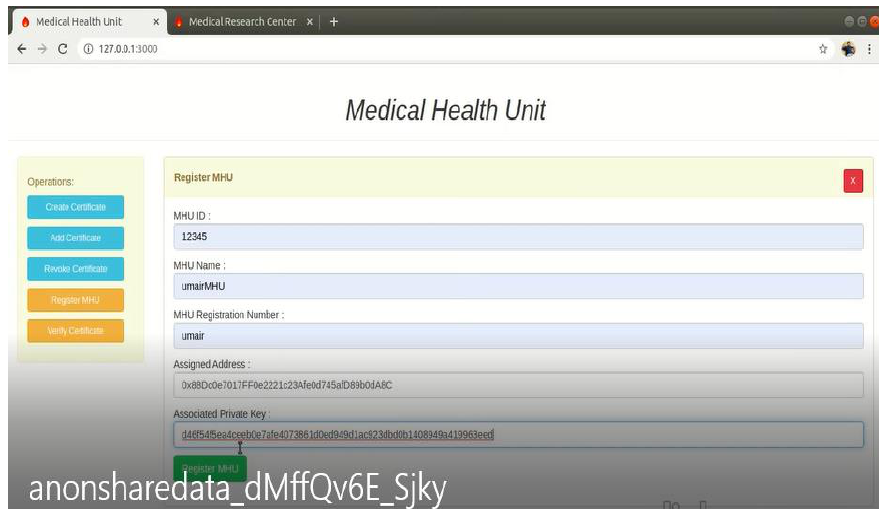
Figure 9. Blockchain-powered secured dashboard for the medical research center in order to preserve the records’ privacy with/using